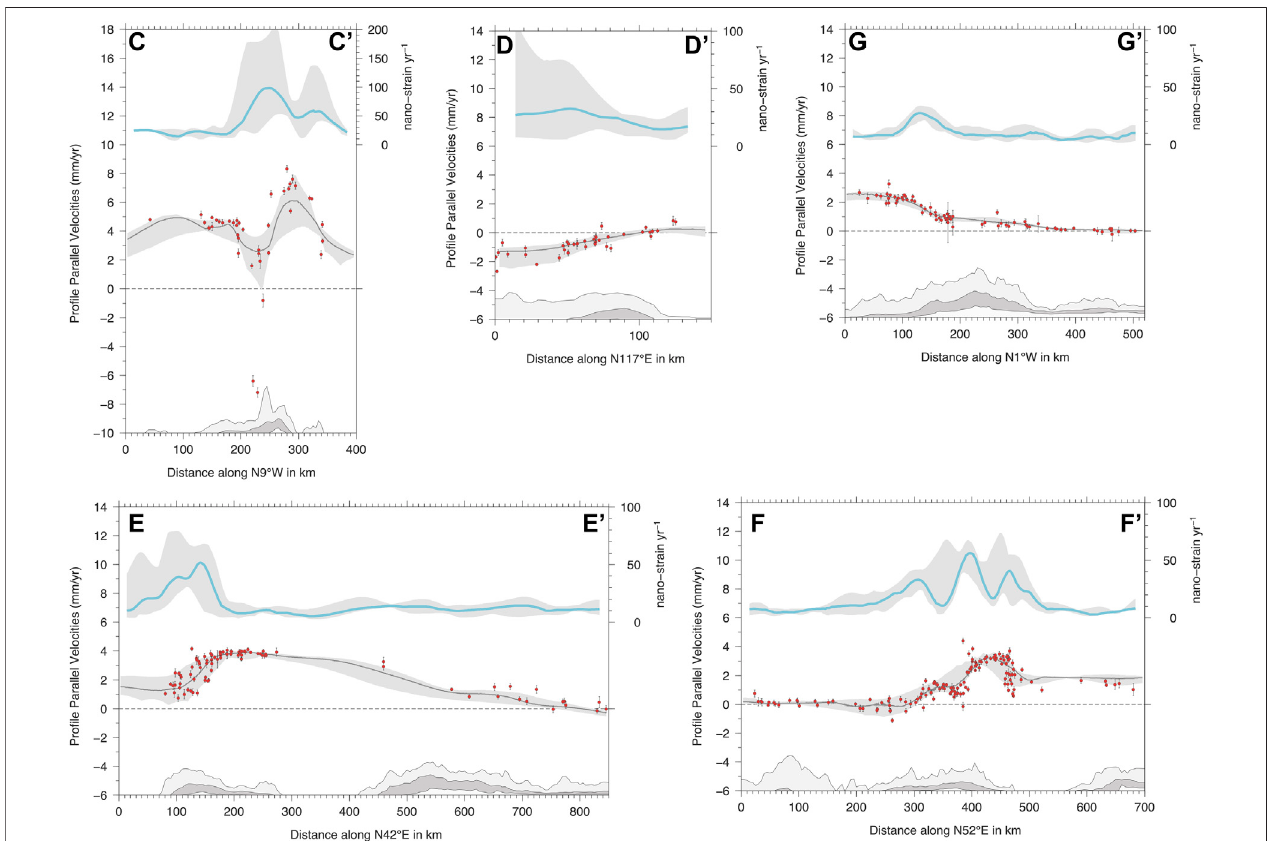
FIGURE 13 | Same as Figure 11 for cross sections in the Central Mediterranean (see Figure 9 ) across Sicily (B-B ’ ), the Calabrian Arc (C-C ’ ), the Southern Apennines and southern Dinarides (D-D ’ ), the Northern Apennines and northern Dinarides (E-E ’ ) and the Eastern Alps (F-F ’ ).